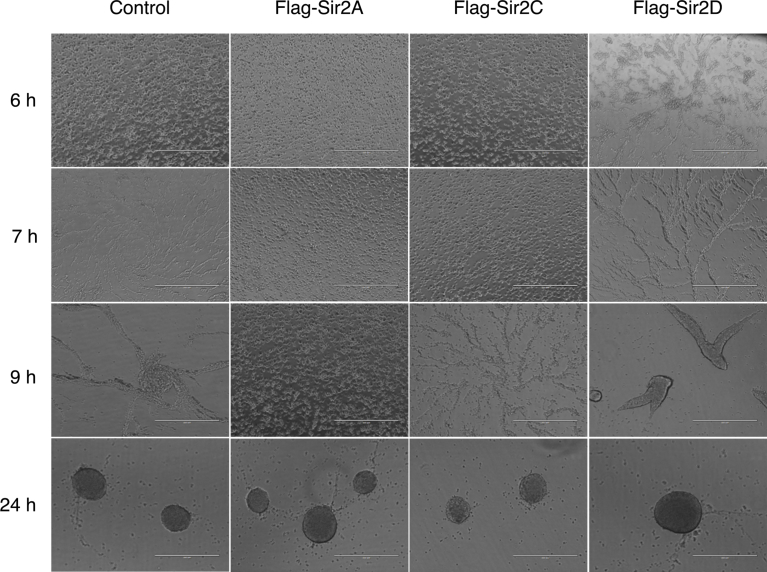
Supplementary Fig. S2.eps